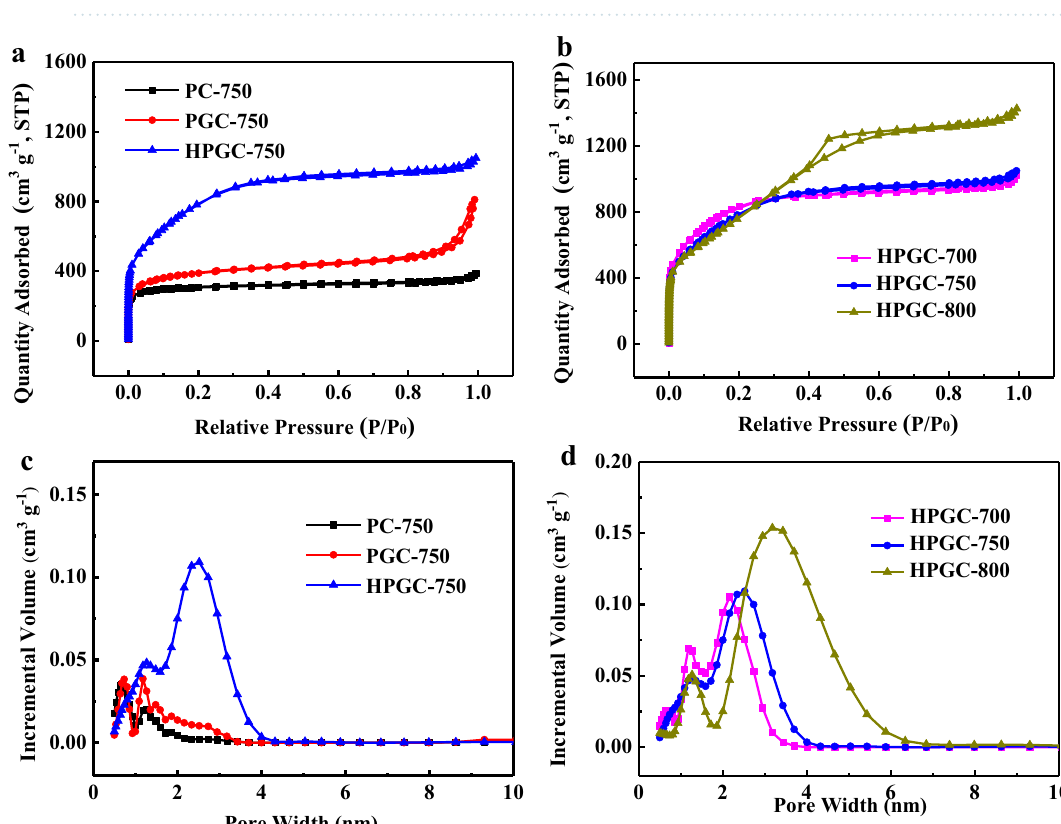
Figure 3. ( a ) N 2 adsorption–desorption isotherms and ( c ) the pore size distribution curves of PC-750, PGC- 750, and HPGC-750; ( b ) N 2 adsorption–desorption isotherms and ( d ) the pore size distribution curves of HPGC- T